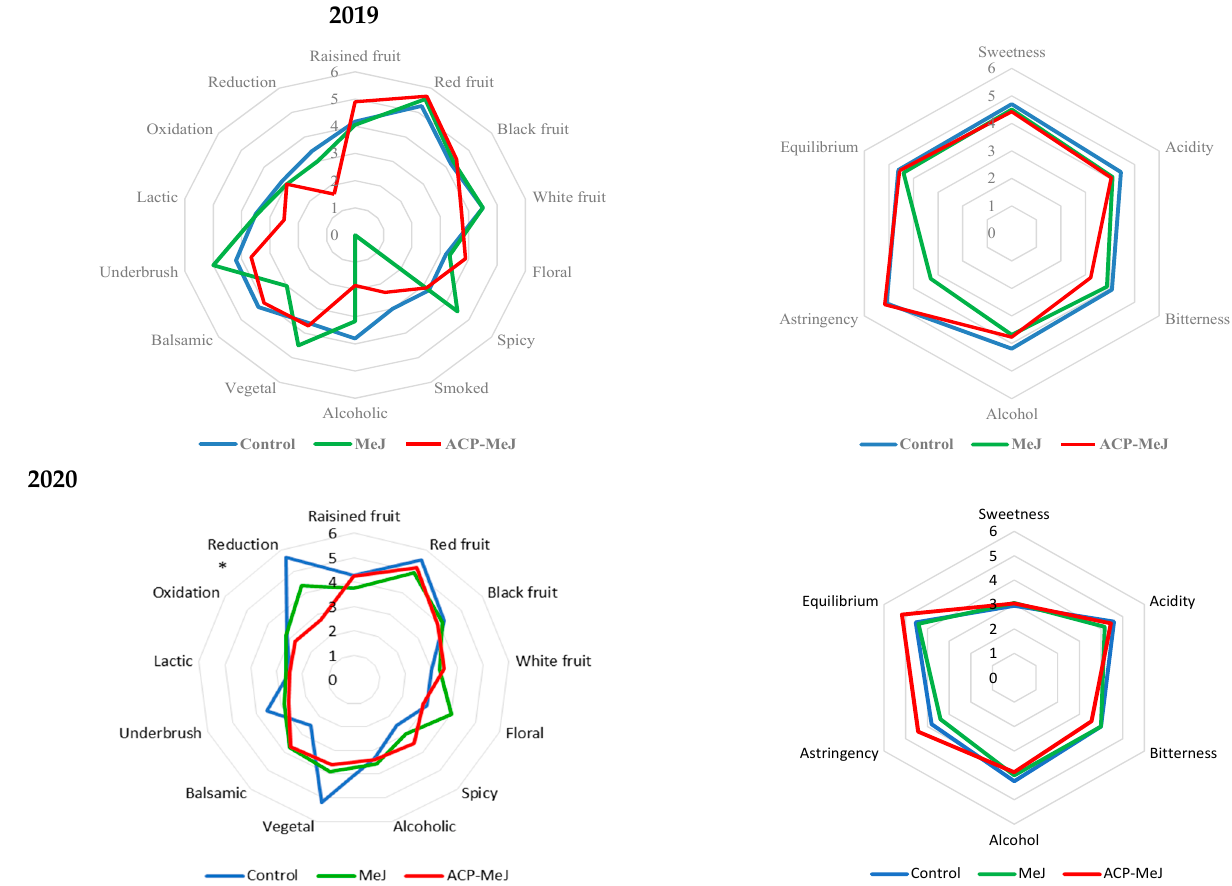
Figure 3. Polar coordinate (spider web) plot of mean intensity ratings of sensory descriptors (odor and taste attributes) for control wines and from methyl jasmonate (MeJ) and apatite doped with methyl jasmonate (ACP-MeJ) treatments, in the two seasons (2019 and 2020). At the origin, intensity = 0; at the perimeter, intensity = 6. * indicates significant differences between treatments ( p ≤ 0.05).